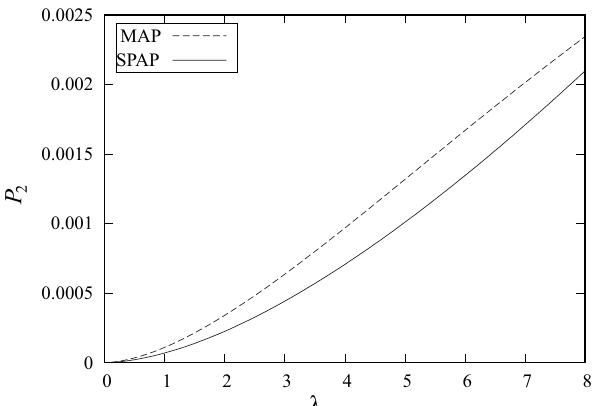
Figure 4. Dependence of the probability P 2 that a customer meets the server, having status 2 upon arrival, on the average arrival rate λ .